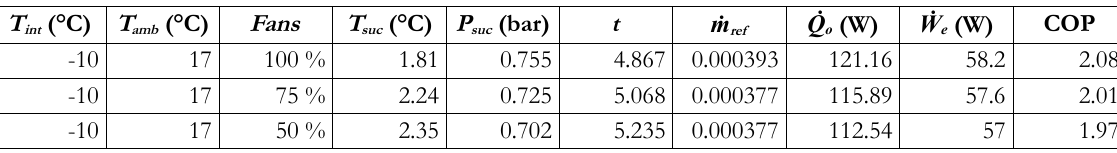
Table 1. COP values of the ITF CAN